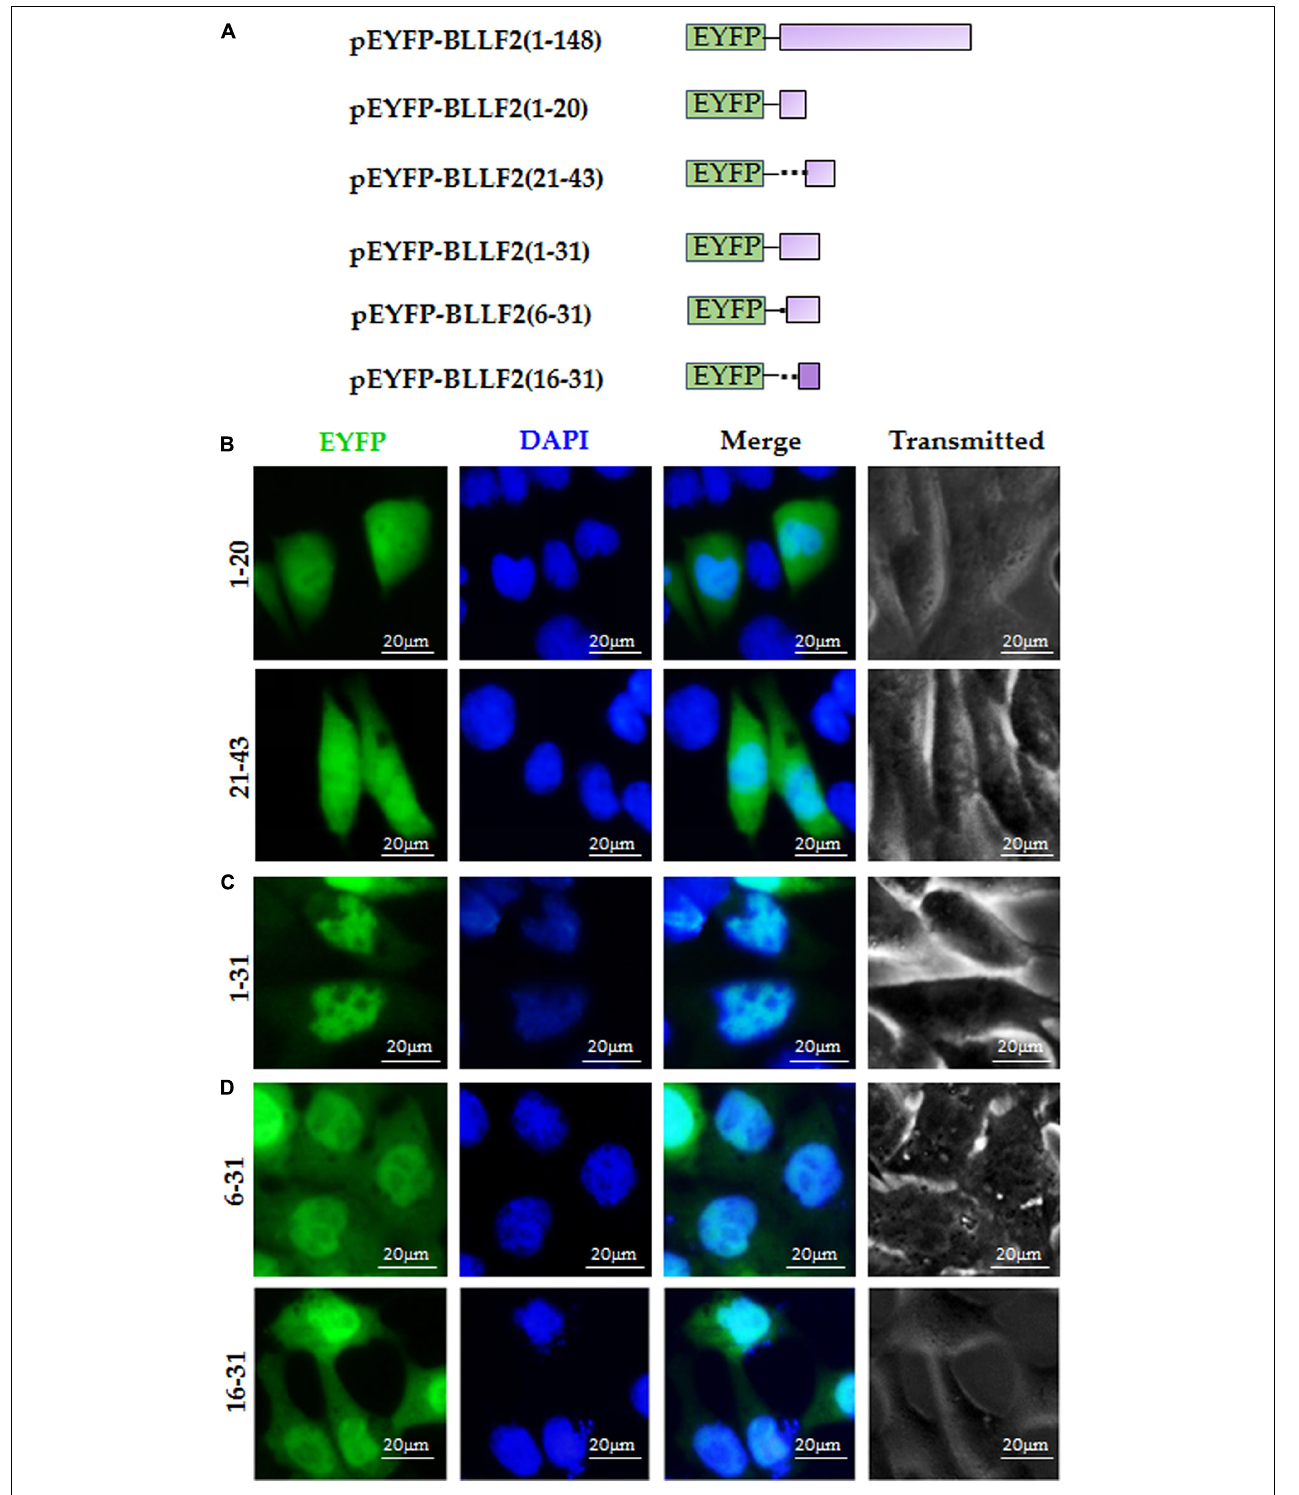
FIGURE 3 | aa16–31 is another functional NLS of BLLF2. (A) Schematic diagram of constructs encoding EYFP-tagged wild-type BLLF2 and its deletion mutants aa1–20, 21–43, 1–31, 6–31, and 16–31. (B) Intracellular localization of deletion mutants BLLF2(1–20) and BLLF2(21–43) in COS-7 cells. (C) Intracellular localization of deletion mutant BLLF2(1–31) in COS-7 cells. (D) Intracellular localization of deletion mutants BLLF2(6–31) and BLLF2(16–31) in COS-7 cells. All scale bars indicate 20 µ m.